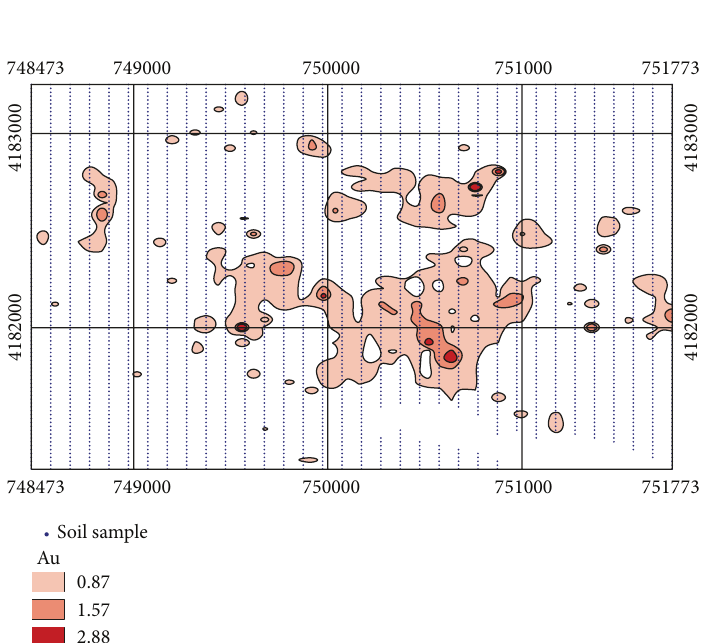
Figure 7: The isogram of Au after processing by the FICAA.